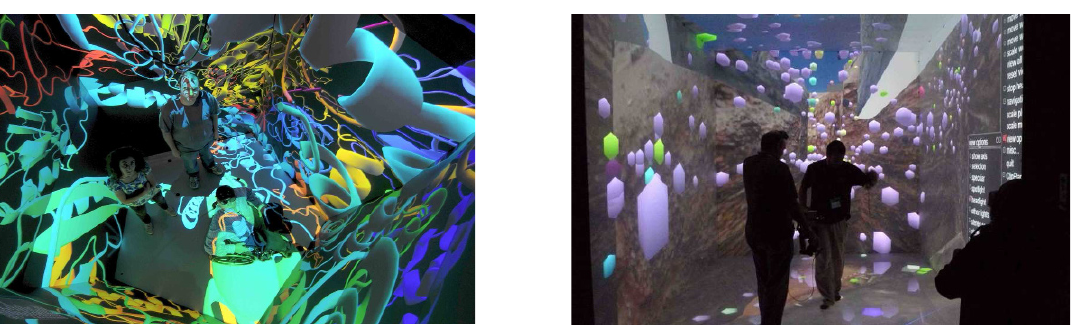
Figure 6. Cornea with users. Content: Tom Levy, Kyle Knabb, and Jurgen Schulze. Photo: Tom